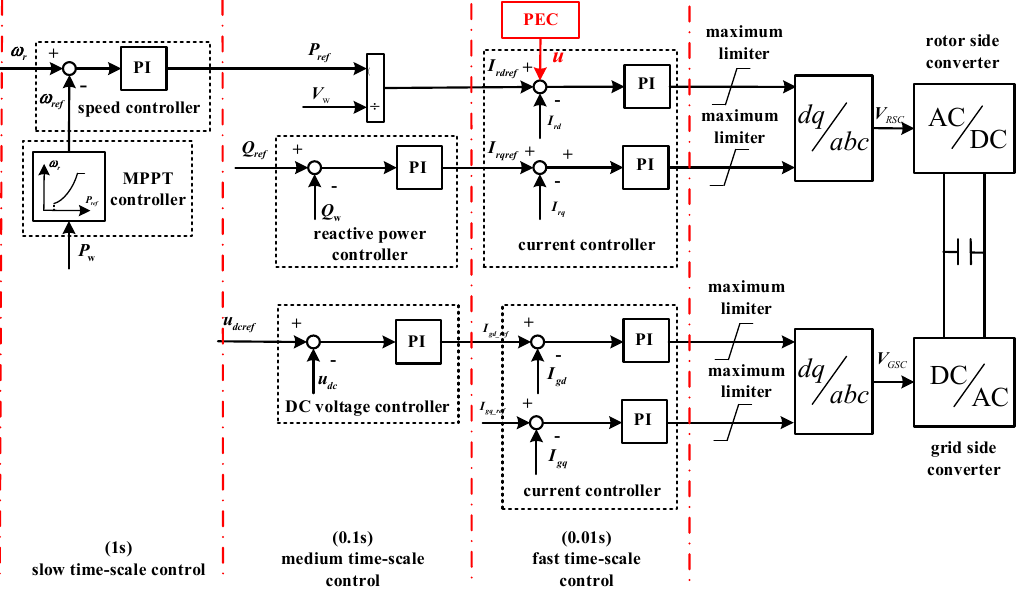
Figure 4. Scheme of converter controller.